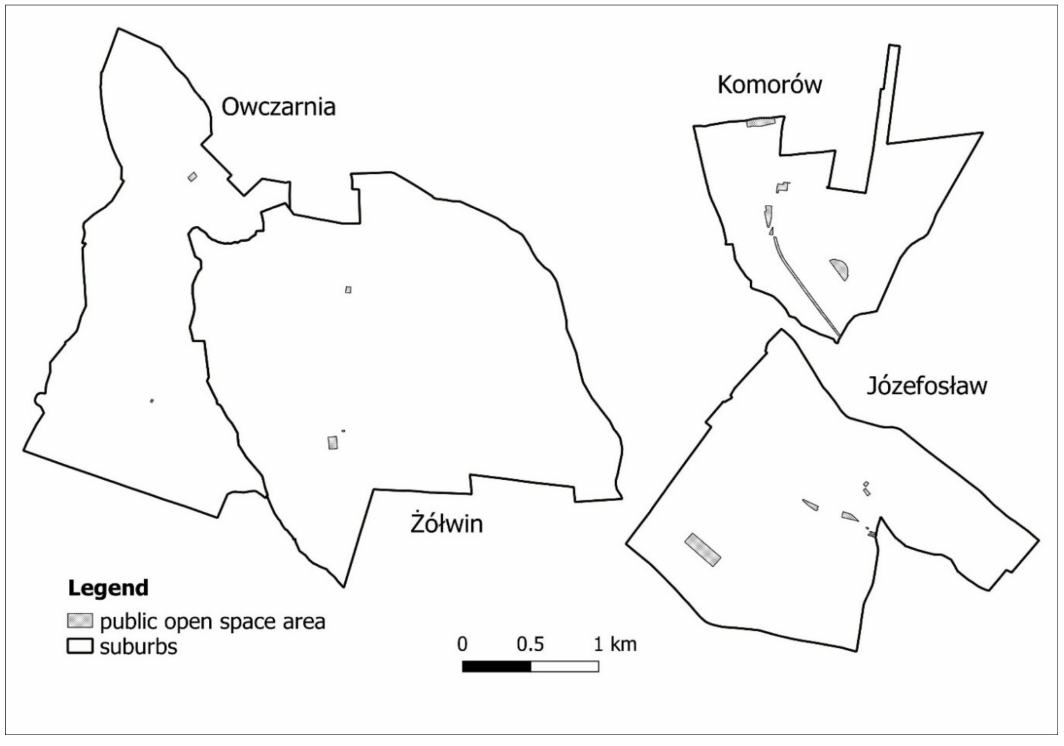
Figure 4. Open space